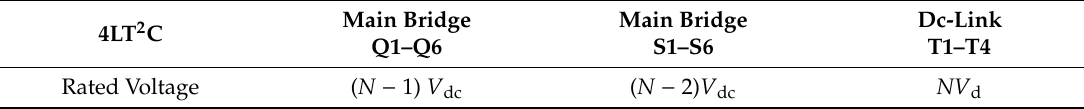
Figure 11. A prototype of the proposed 4LT 2 C. Table 8. N -level T-Type inverter component